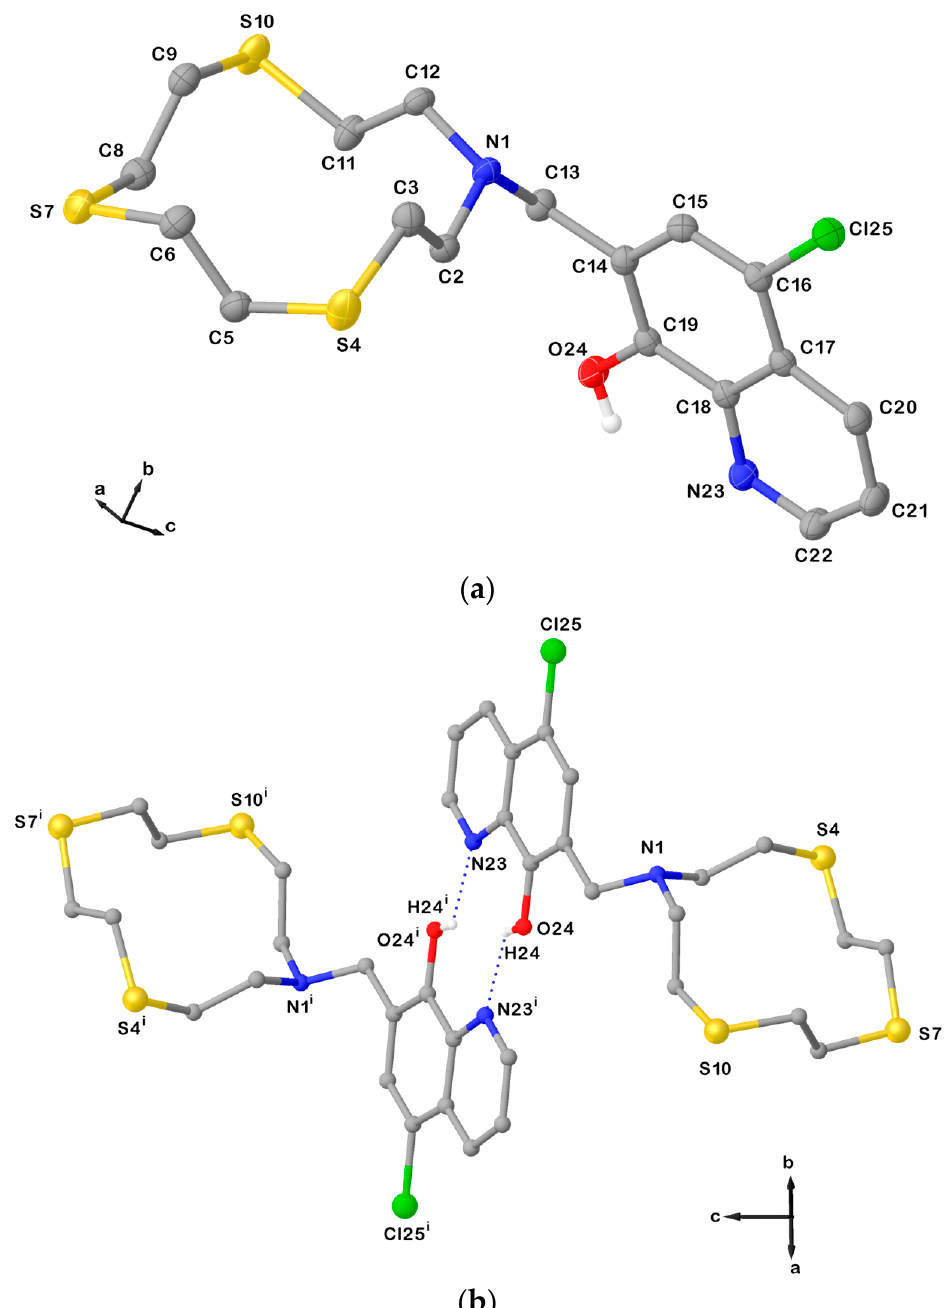
Figure 3. ( a ) View of the asymmetric unit of L12 with the atom-labelling scheme adopted. Hydrogen atoms are omitted for clarity. Displacement ellipsoids are drawn at 50% probability level; ( b ) H-bonded dimeric arrangement found in L12 with the numbering scheme adopted. Only interacting hydrogen atoms are shown for clarity. N23 ··· O24 i = 2.8514(6) Å; O24 i − H24 i ··· N23 = 135 ◦ ; and symmetry operation: i = − x, − y, 2 − z. For selected bond lengths (Å) and angles ( ◦ ), see Table S2 in the Supplementary Materials.